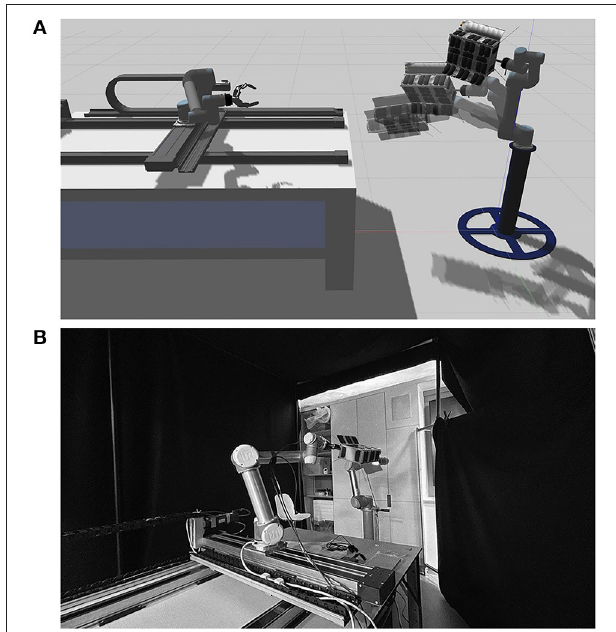
FIGURE 7 | The STAR-LAB’s testbeds for orbital space robotic Guidance, Navigation, and Control (GNC) systems (A) is the digital simulation testbed build in ROS gazebo environment; (B) the design and setup configuration of the STAR-LAB orbital robotic testbed in monochrome format is shown.